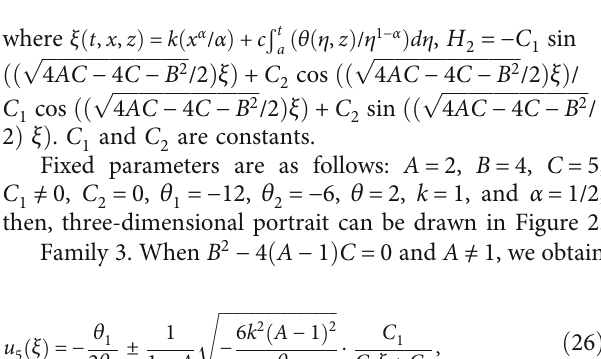
Figure 1: The solution u parameter.